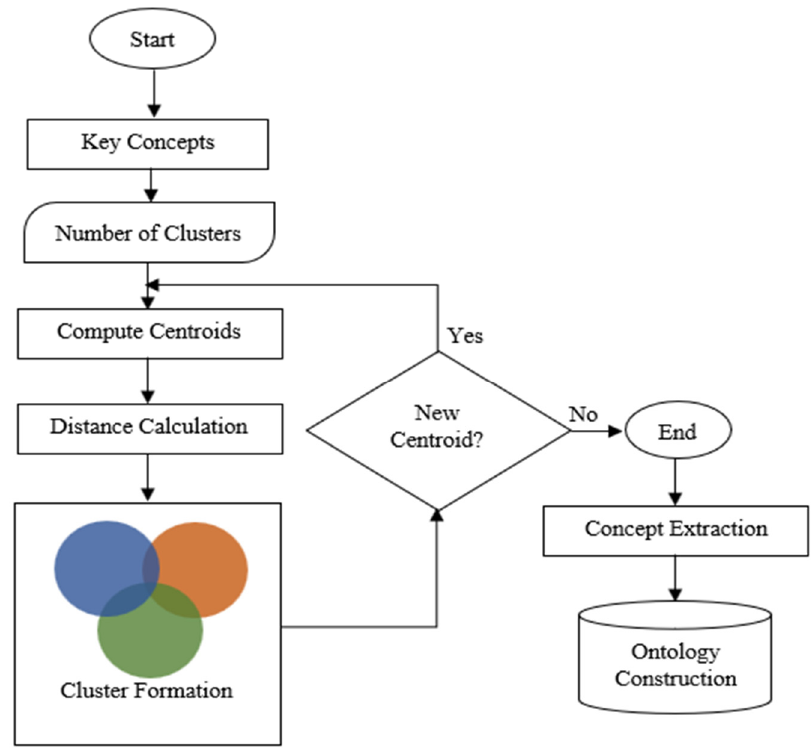
Figure 6. Flow chart of concept clustering using the Fuzzy C-Mean algorithm.